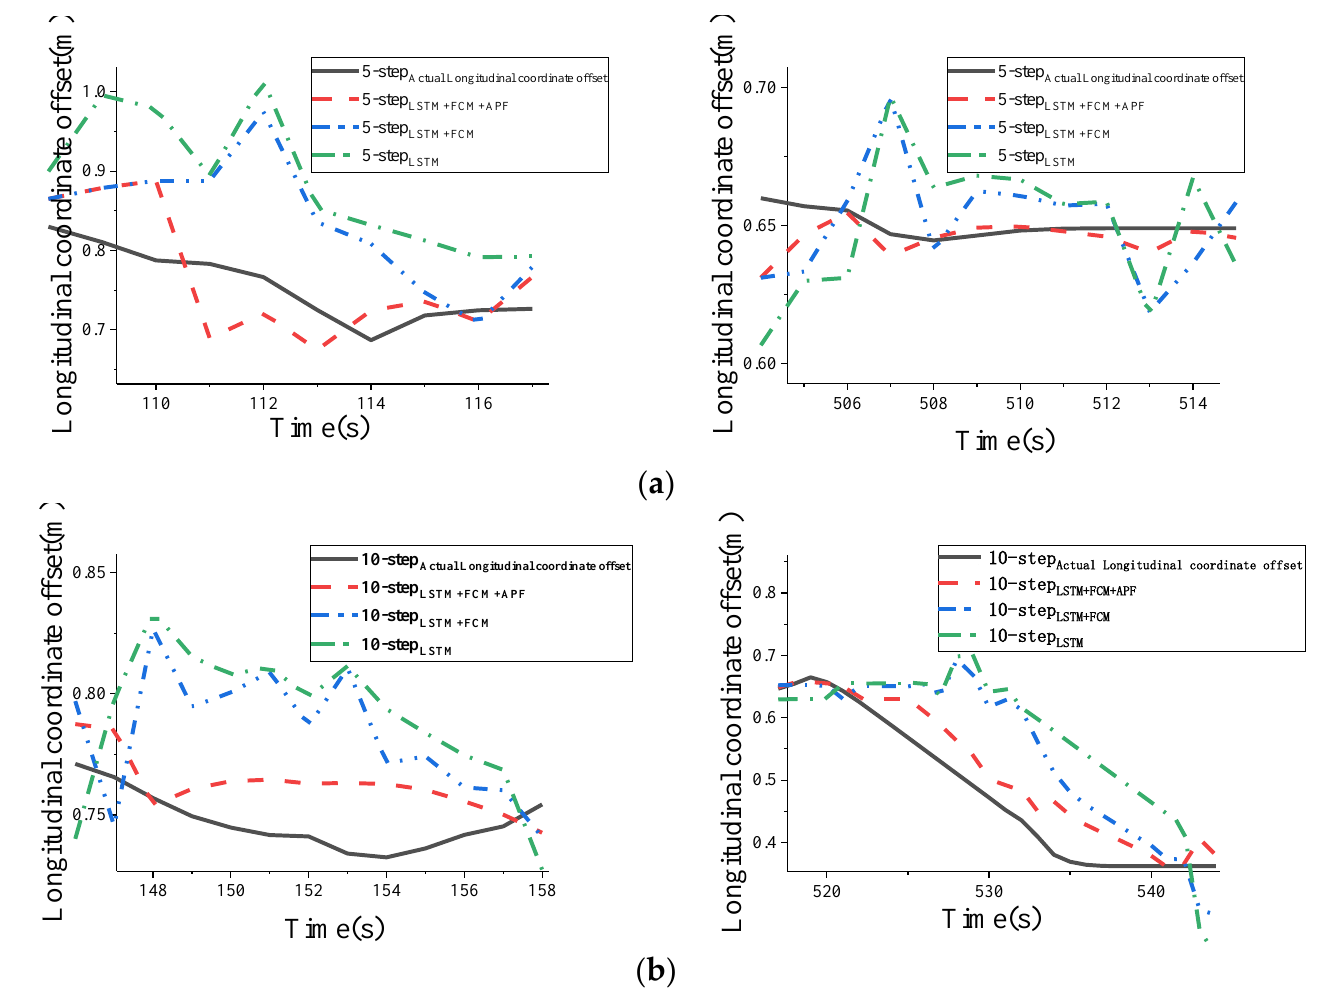
Figure 5. Lateral coordinate prediction results: ( a ) lateral coordinate 5 − step prediction results and ( b ) lateral coordinate 10 − step prediction results.